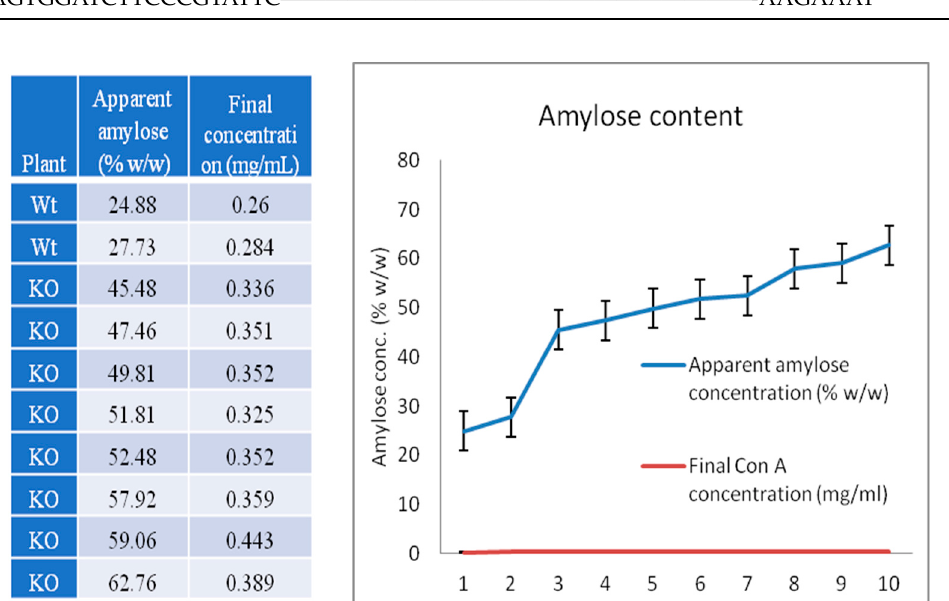
Figure 7. Changes in the apparent concentration of amylose (percentage w/w ) versus final Con A concentration (mg/mL) in control (wt) and mutant transgenic rice grains.